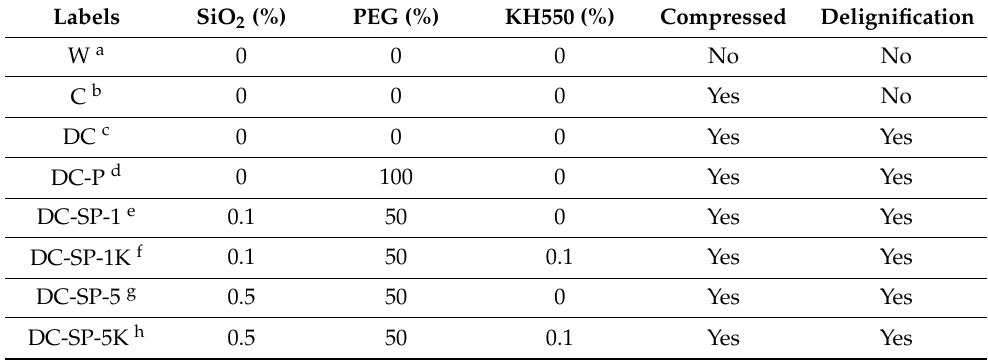
Table 1. Labeling of various treatment